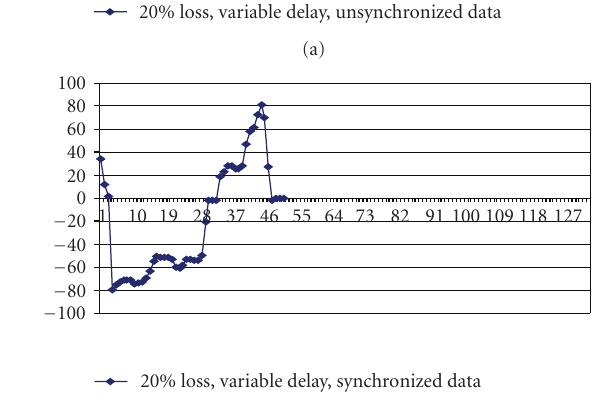
Figure 14: (a) 20% Loss with Variable delay, unsynchronized data. (b) 20% Loss with Variable delay, synchronized data.